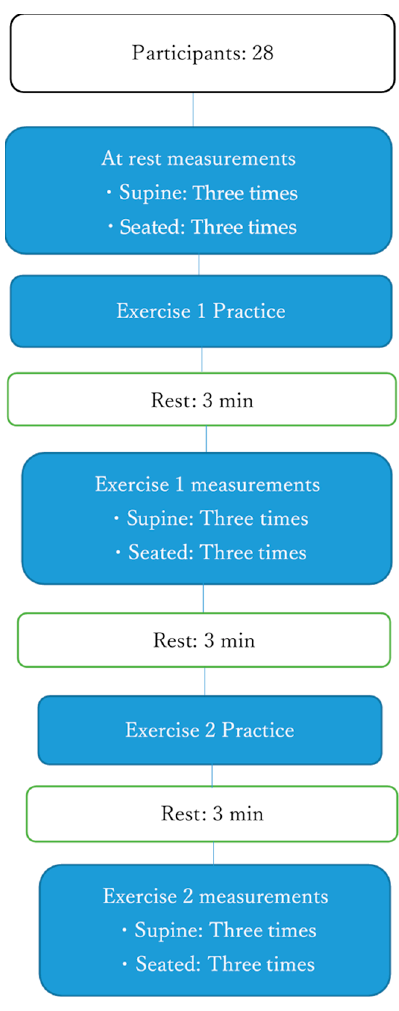
Figure 2. Experimental flow. The participants were randomly assigned to perform Exercise 1 and Exercise 2 to determine the di ffi culty of performing abdominal draw-in maneuver (ADIM) and abdominal bracing (AB) exercises. The measurements for the sitting or supine position were randomly selected.